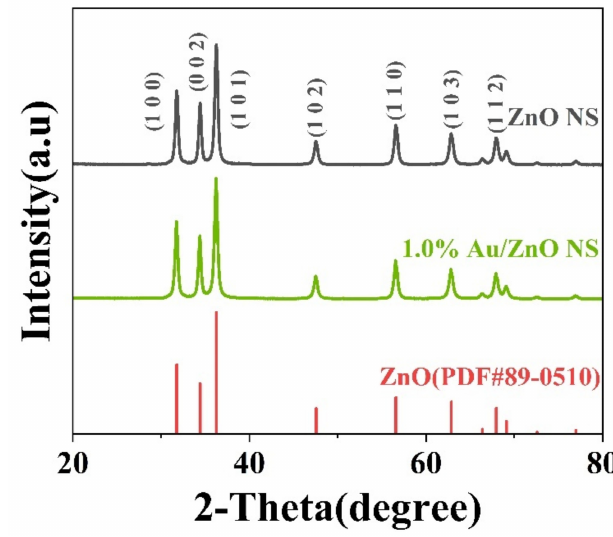
Figure 2. XRD patterns of ZnO NS and 1.0% Au/ZnO NS.